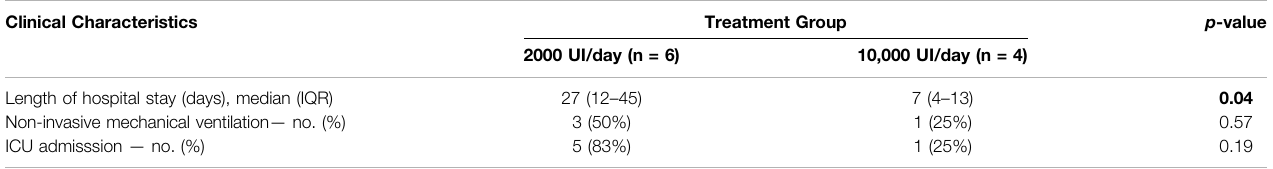
TABLE 5 | Clinical characteristics in hospitalized patients with COVID-19 who developed acute respiratory distress syndrome (ARDS) during treatment with 2000 IU/day or 10,000IU/day of cholecalciferol. Clinical Characteristics